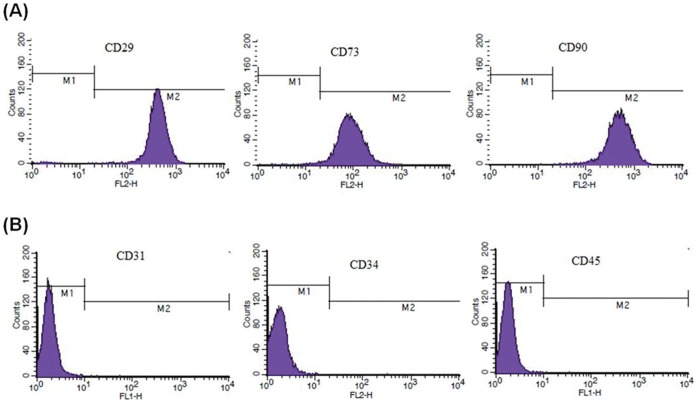
Flowcytometric analysis of surface markers on cultured hATMSCs.(A) MSC-specific markers CD29, CD73, CD90 and CD105 were expressed on culture hATMSCs. (B) Hematopoietic stem cell markers CD31, CD34 and CD45 were not expressed.